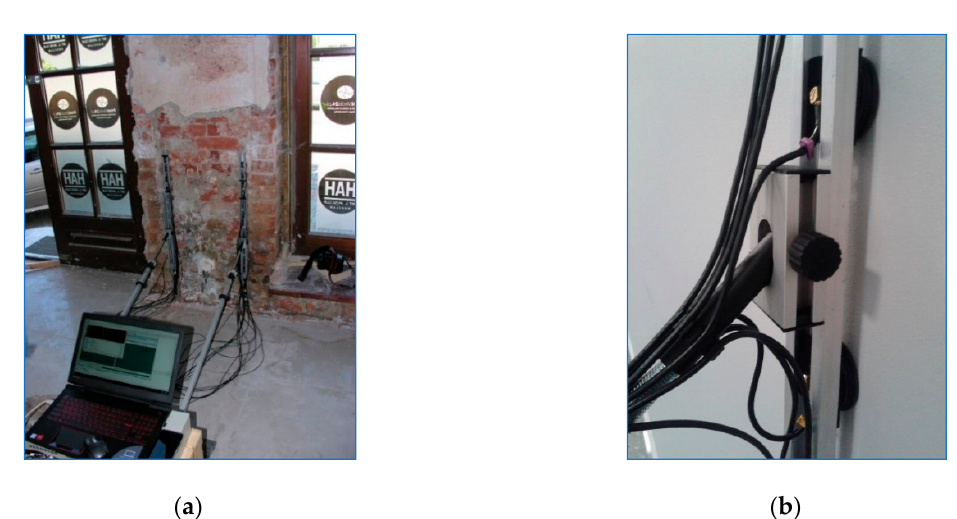
Figure 5. The method of carrying out humidity measurements with the EIT tomograph: ( a ) tomograph with electrodes placed on special rails, ( b ) design of the rail with electrodes